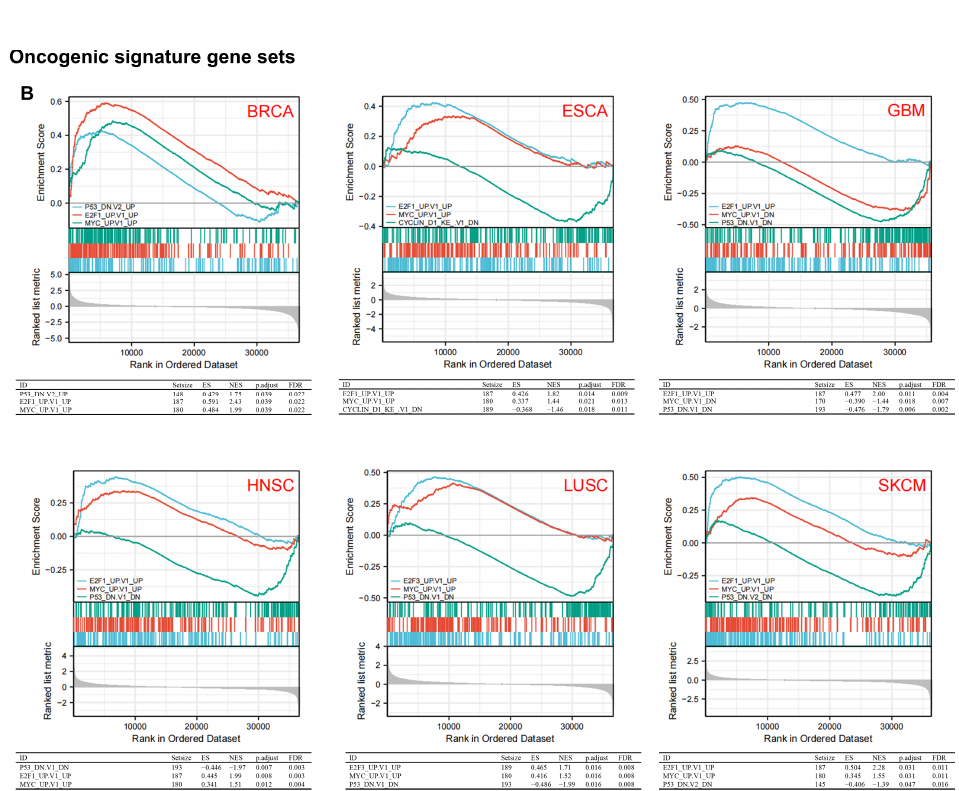
Figure 6. Gene set enrichment analysis of KIFC1. ( A ) Hallmark gene sets enriched in high KIFC1 expression group. ( B ) Oncogenic signature gene sets enriched in high KIFC1 expression group. ES: enrichment score; NES: normalized enrichment score; FDR: false discovery